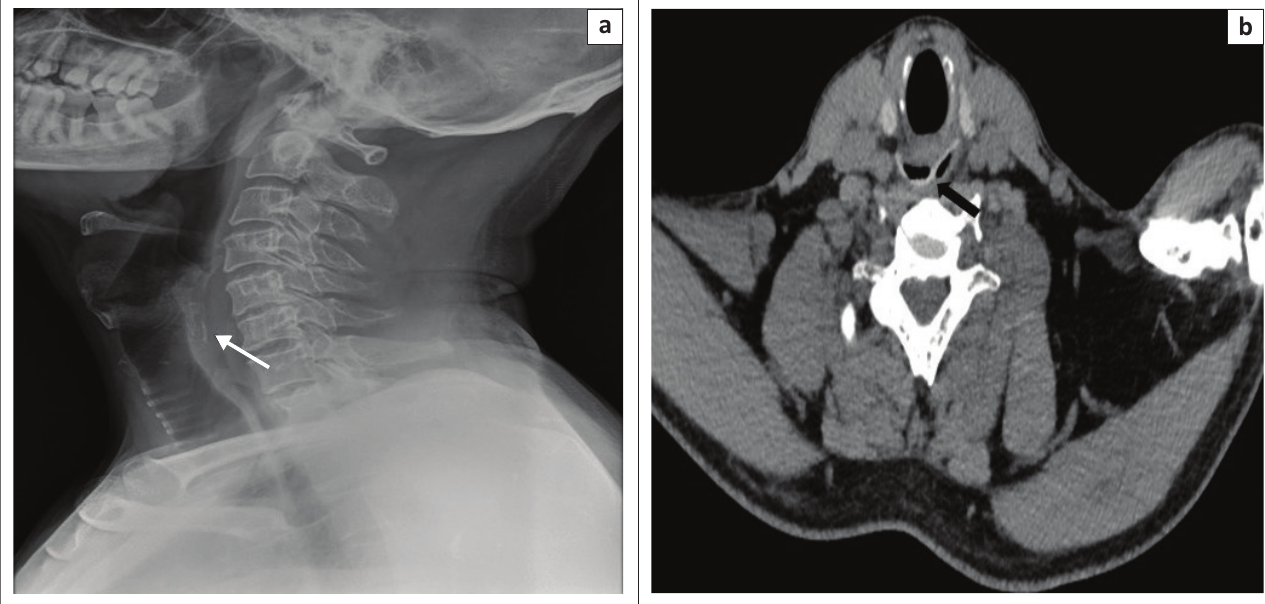
FIGURE 6: (a) Lateral radiograph of the neck revealing a swallowed denture (thin arrow) at the level of the cricopharynx. (b) Axial computed tomography image confirms the location of the denture (thick arrow), which appears as a curvilinear hyperdense structure.